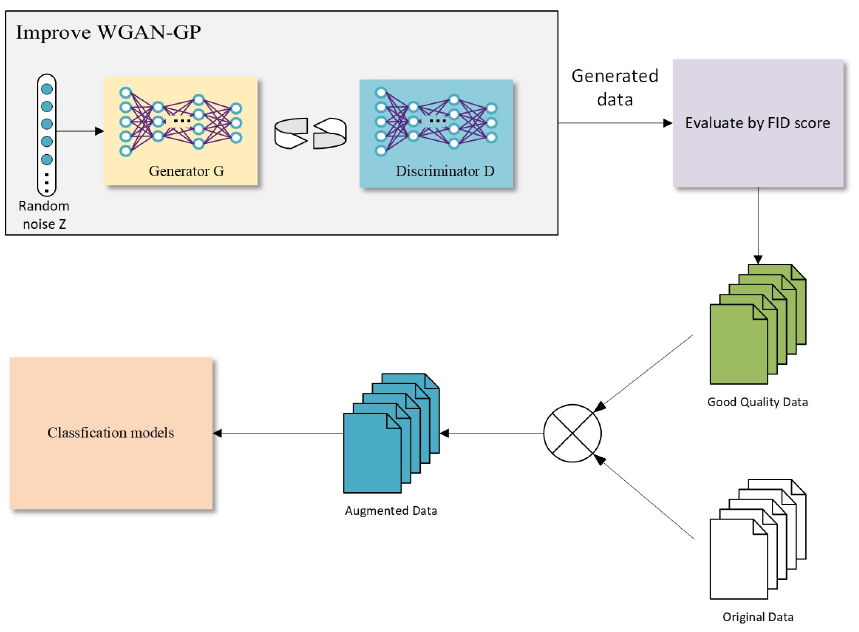
Figure 10. Flow chart of the experimental